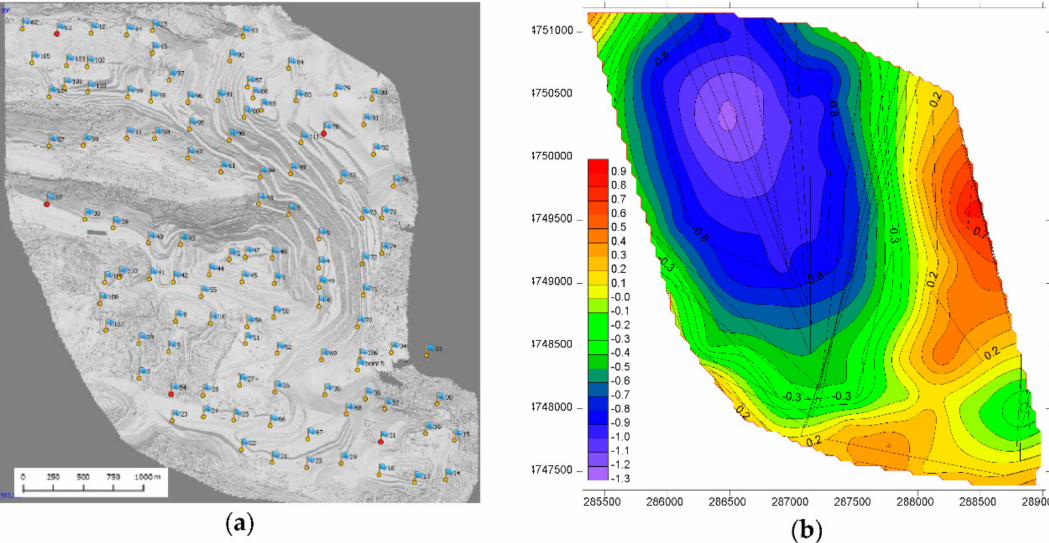
Figure 11. Altitude error when few control points are used. ( a ) The location of the five control points used for georeferencing a specific GCP-BA (flags with a red base). ( b ) The altitude errors (in meters) measured in check points. Here, the reference system is ETRS89 projected according to UTM zone